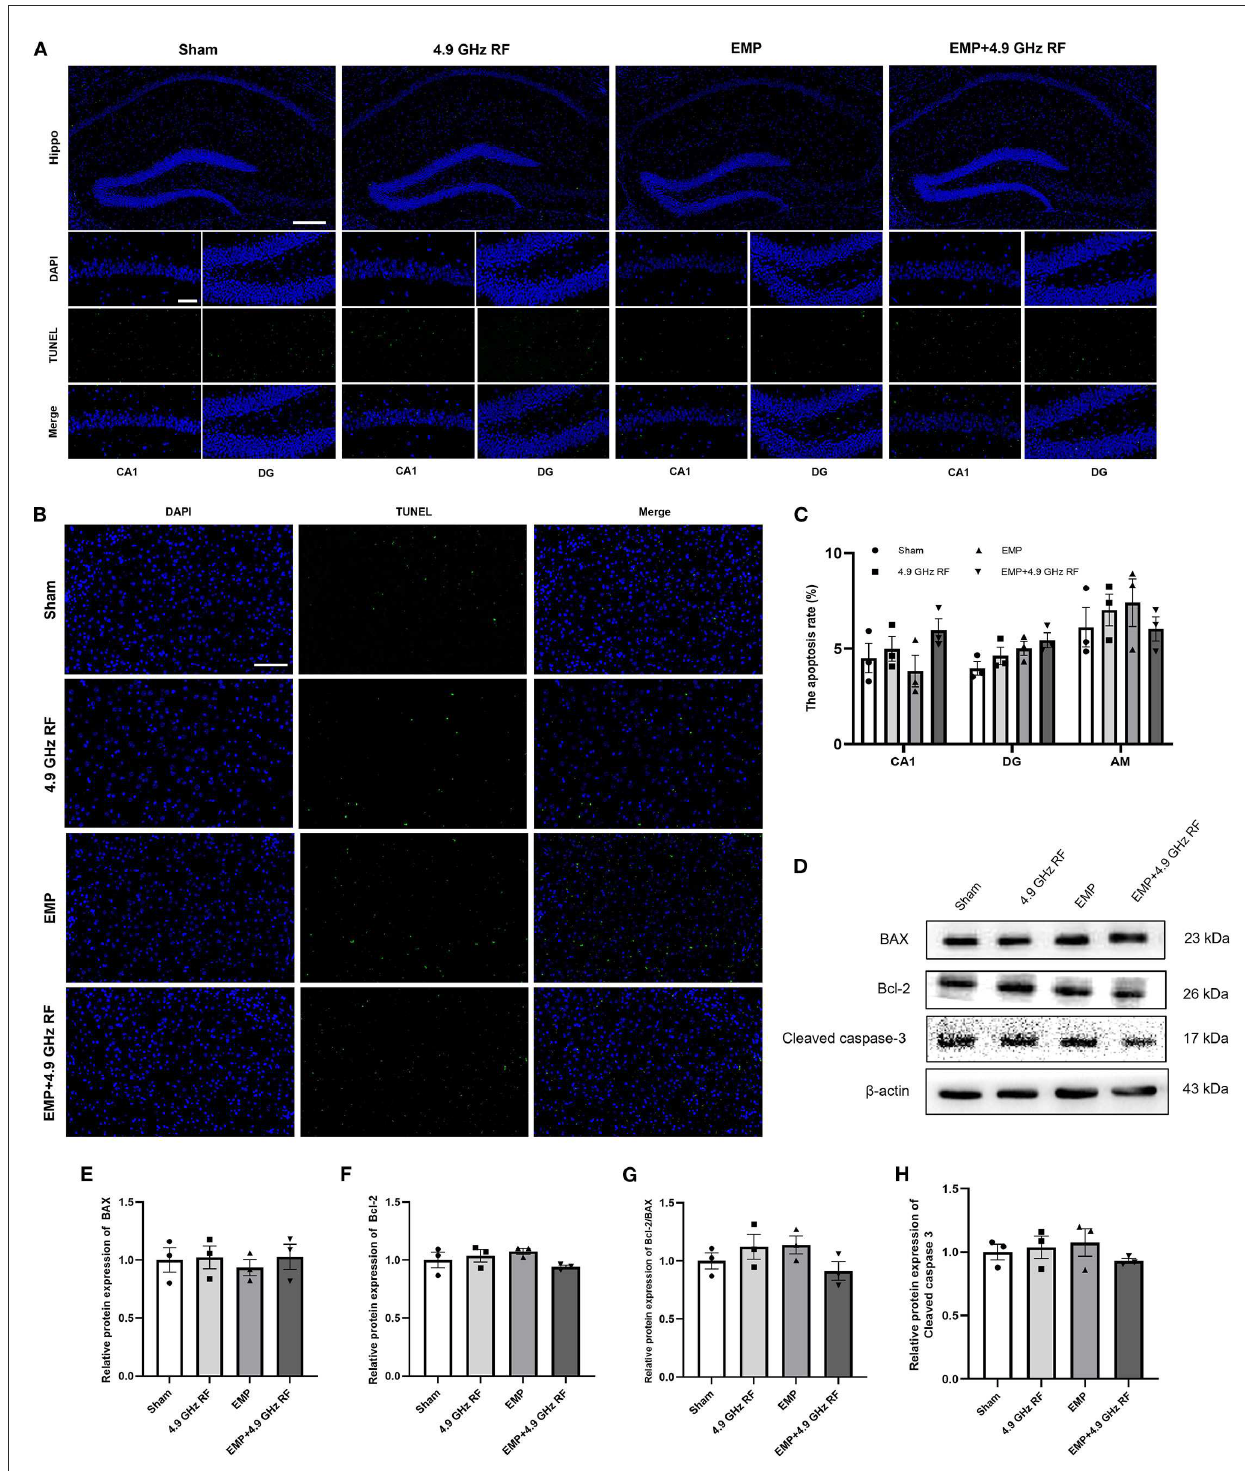
FIGURE7 The combined effects of exposure to EMP and 4.9 GHz RF on apoptosis in hippocampus and amygdala. (A) Result of TUNEL staining of hippocampus. (B) Result of TUNEL staining of amygdala. Scale bar = 100 µ m for Hippo, scale bar = 50 µ m for CA1, DG and amygdala regions. (C) Quantitative analysis of apoptosis rate. (D) The levels of apoptosis-related proteins were detected by western blot. Relative protein expression levels of Bax (E) , Bcl-2 (F) , Bcl-2/Bax (G) and Cleaved caspase 3 (H) in hippocampus. n = 3 for each group.